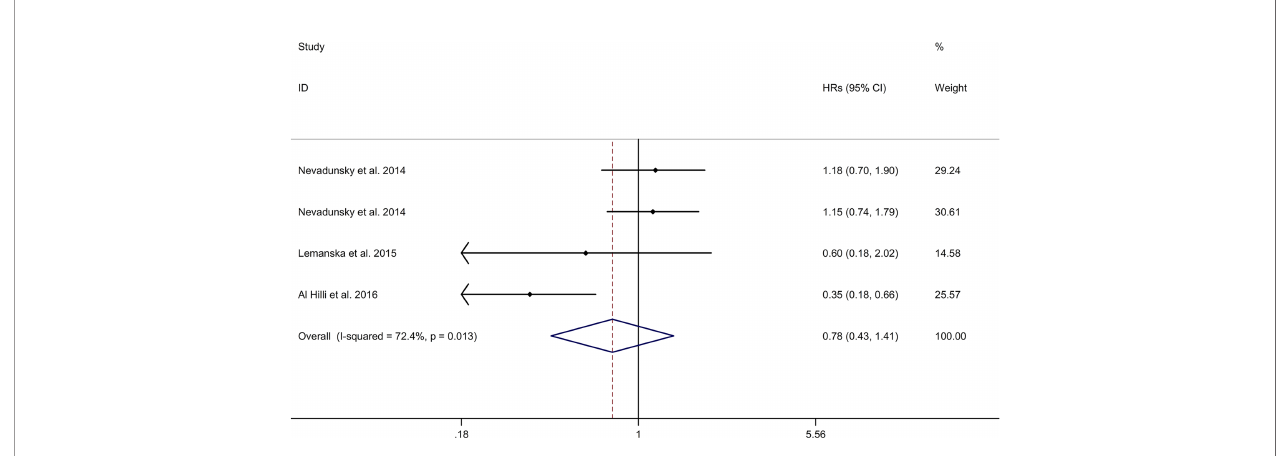
FIGURE 6 | Forest plots of association between metformin use and cancer-speci fi c survival of